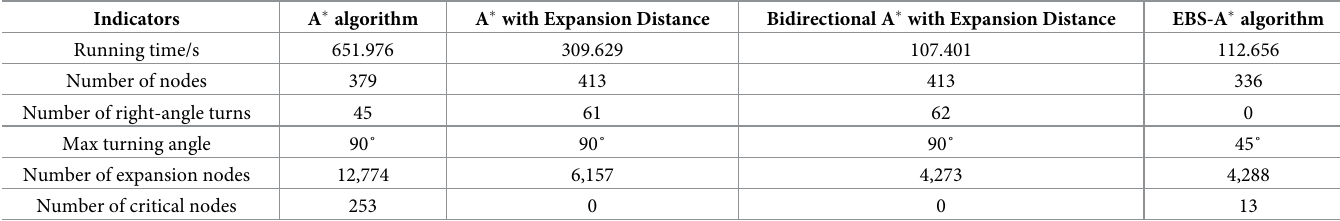
Table 7. Simulation results of four algorithms on a 200 × 200 map.